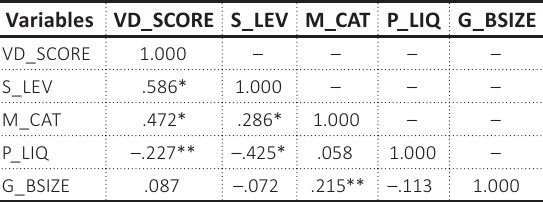
Table 3. Correlation